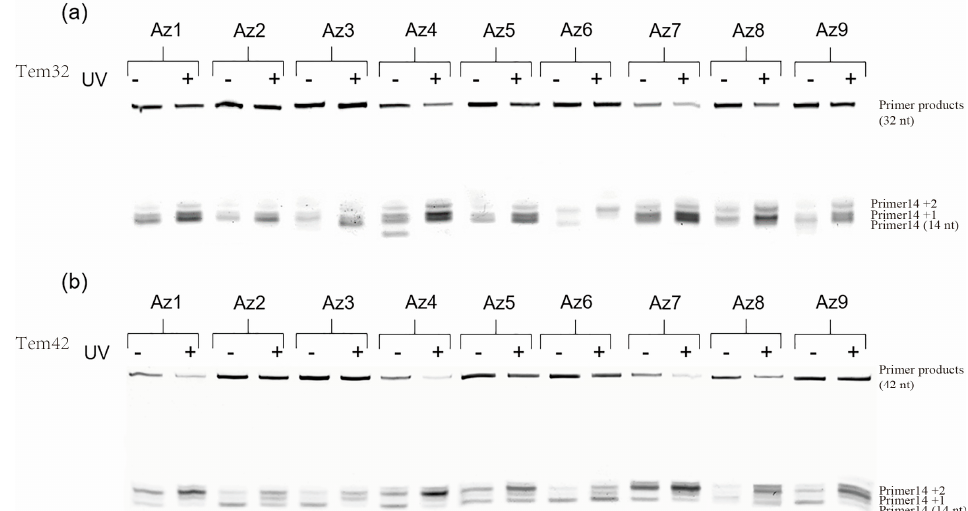
Figure 5. Denaturing PAGE (20%) of photomodulation of the primer extension reactions using ( a ) Tem32 or ( b ) Tem42 as template. Polymerization reactions without or with UV irradiation were performed for a long period of time (90 min) at 37 °C.